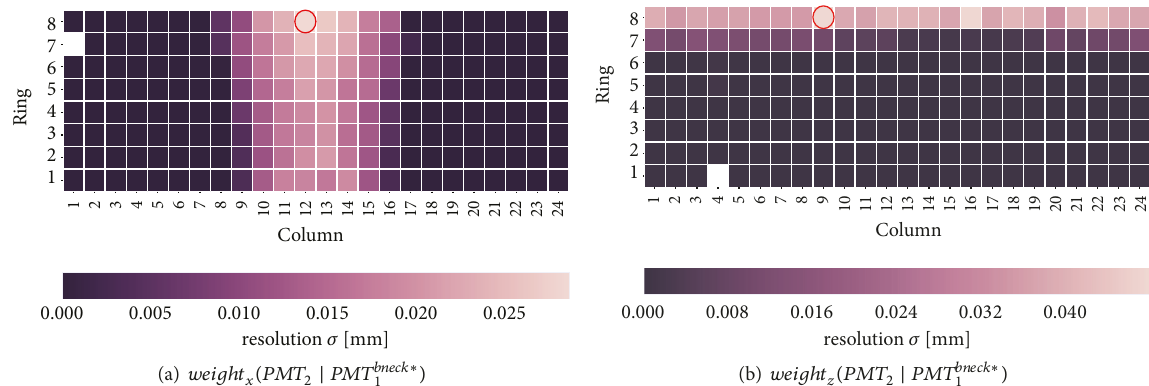
Figure 6: Weights as given by the bottleneck neuron corresponding to using a second candidate PMT, and the most important PMT, 𝑃𝑀𝑇 𝑏𝑛𝑒𝑐𝑘∗ 𝑥 and (b) 𝑧 . 𝑃𝑀𝑇 𝑏𝑛𝑒𝑐𝑘∗ 1 , as identified previously for (a) 1 is whitened in each figure. In each of the heatmap, the circled PMT, corresponds to the largest weight amongst the remaining 191 PMTs given that the first important PMT has been identified with the bottleneck DNN.